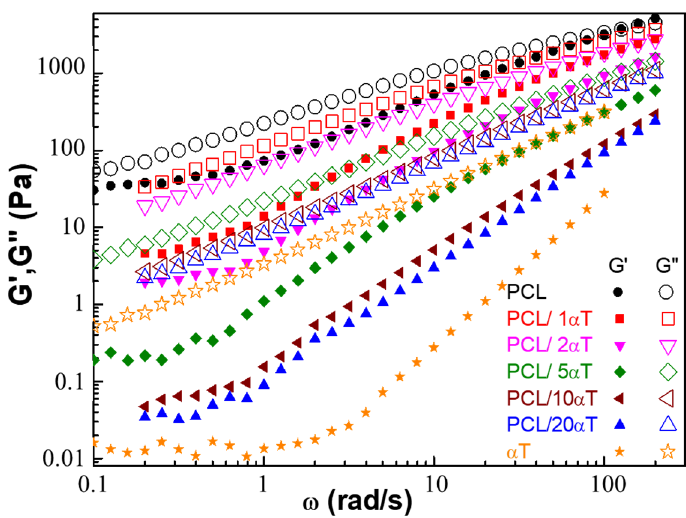
Figure 2. Angular frequency dependence of storage (G ′ , filled symbols) and loss (G ″ , open symbols) moduli for the PCL solutions containing α -tocopherol.